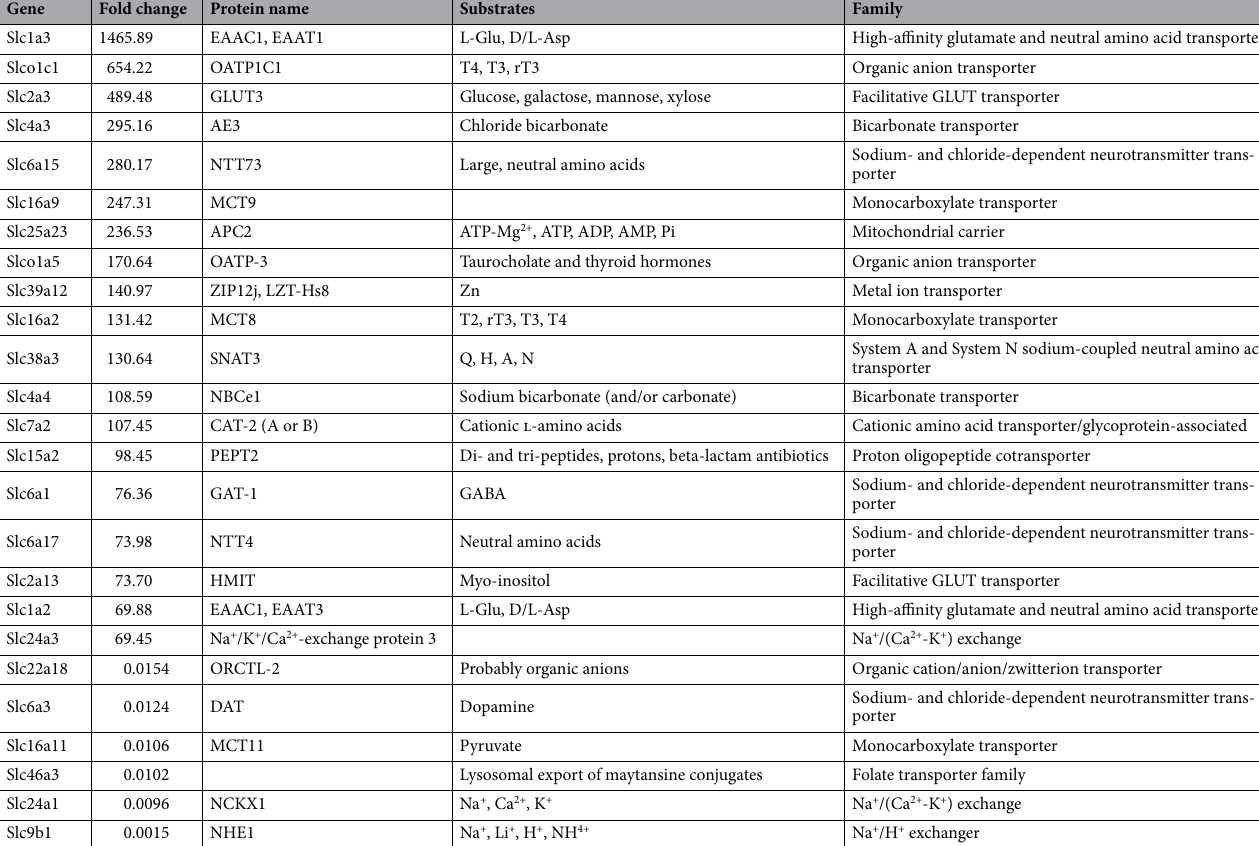
Table 3. Differentially expressed SLC transporters in PVEC vs. ABEC. List of SLC family transcripts whose expression was at least 70-fold higher or lower in PVEC vs.